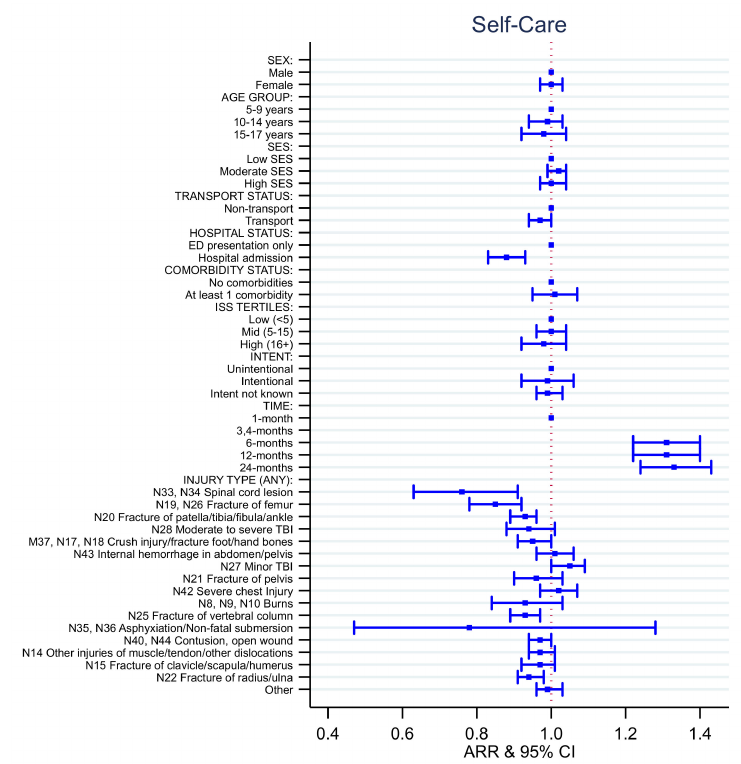
Figure 5. EQ-5D self-care adjusted relative risk (ARR).